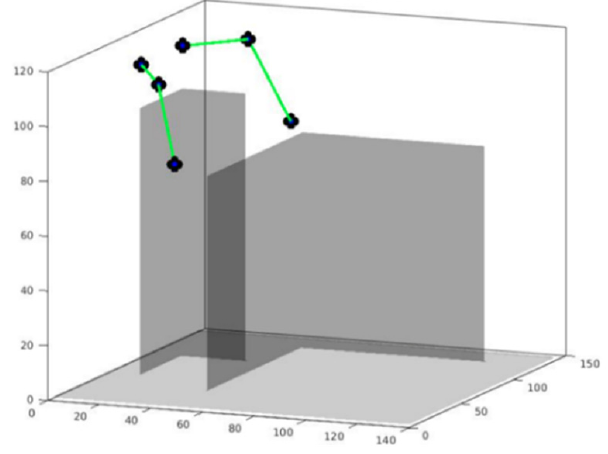
Figure 7. Simulated environment of the manipulative robot ( left ) and a table ( right ).